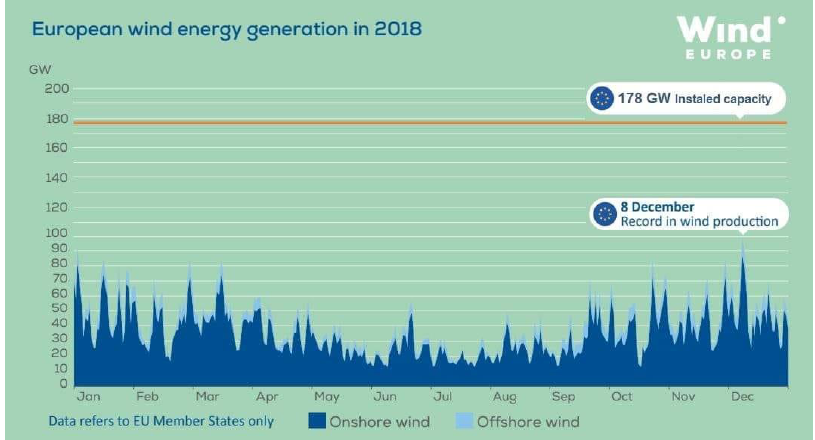
Figure 4. The electrical wind energy generated daily in 2018 in Europe compared to the installed capacity. [https://windeurope.org/about-wind/statistics/european/wind-energy-in-europe-in-2 018/, accessed on 1 August 2022].